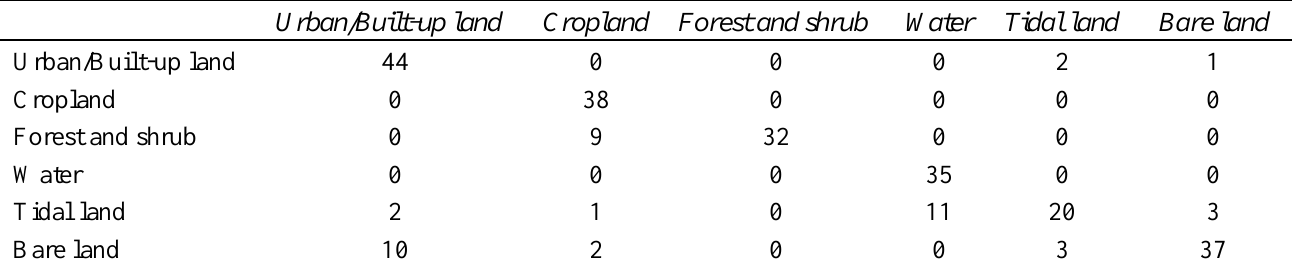
Table 3 Accuracy assessment of land use classification (Kappa index and overall accuracy) for